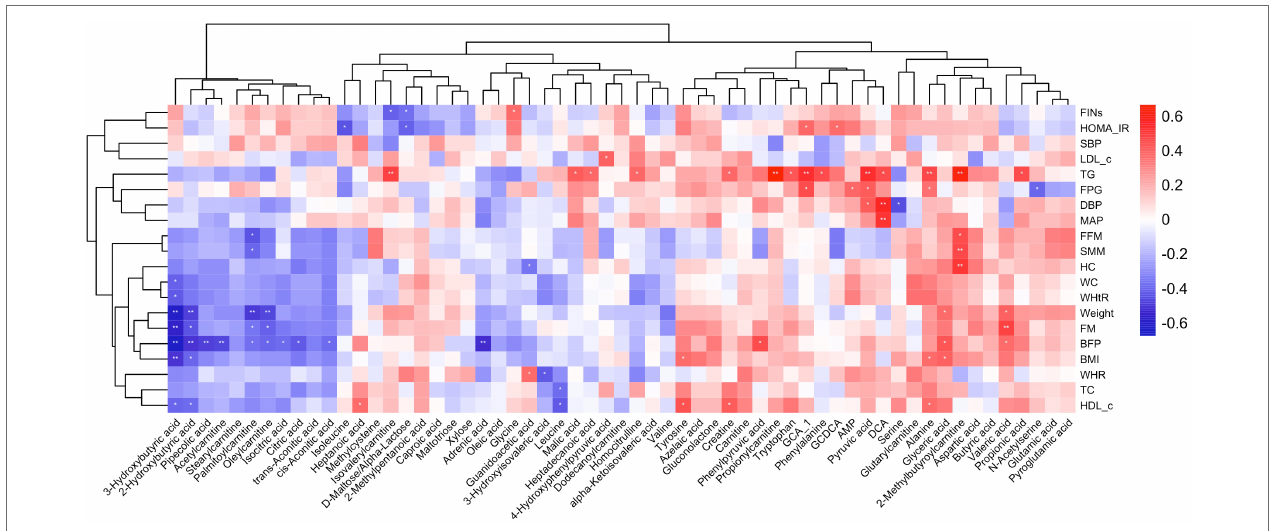
FIGURE 3 | Heat map of the correlations between different metabolites and metabolic improvement. Each square represents the Spearman’s correlation coefficient with the statistical significance threshold set at * p < 0.05, ** p < 0.01. Red and blue colors represent positive and negative correlations,